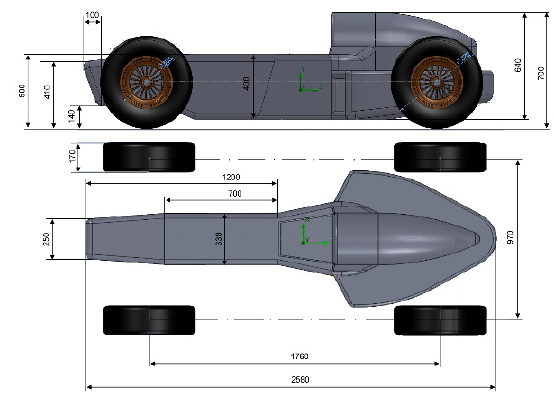
Figure 4. Detail of mesh